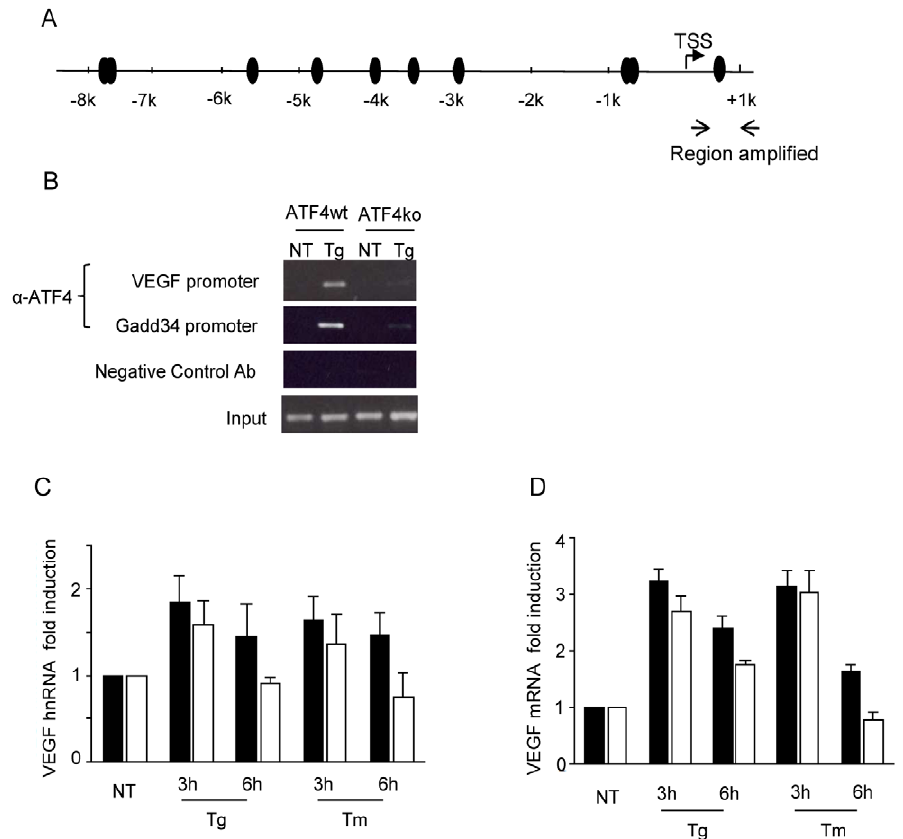
Figure 5. ATF4 contributes to VEGF expression and binds to the mouse promoter in a stress inducible manner. ( A ) Potential ATF4 sites in the mouse VEGF promoter ( B ) Cross-linked chromatin from ATF4 wild-type or null MEFs that were untreated (NT) or thapsigargin-treated (Tg) for 6 h was immunoprecipitated with anti-ATF4 or with a control antiserum (anti-BiP). Precipitated chromatin and input controls were used for PCR amplification. ( C–D ) ATF4 wild-type (black) or null (white) were cultured in normal media (NT), thapsigargin-treated (1 m M), or tunicamycin-treated (2.5 m g/ml) for 3 and 6 hours. Total RNA from the indicated samples was subjected to qRT-PCR, and VEGF hnRNA ( C ) or VEGF mRNA ( D ) levels were determined and represented as described above. Experiments were performed in triplicate (values are mean 6